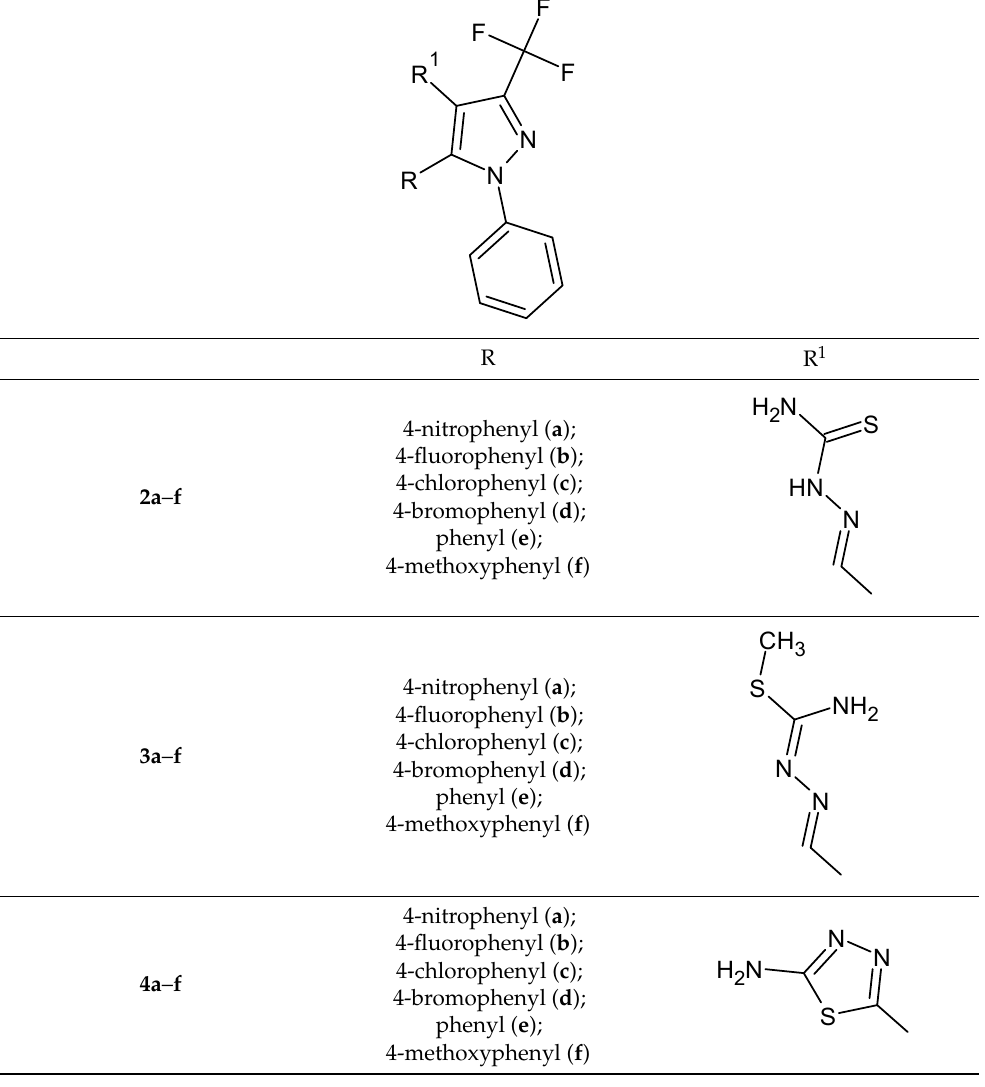
Table 2. The structures of new analogs of trifluoromethylated hybrids of pyrazole.